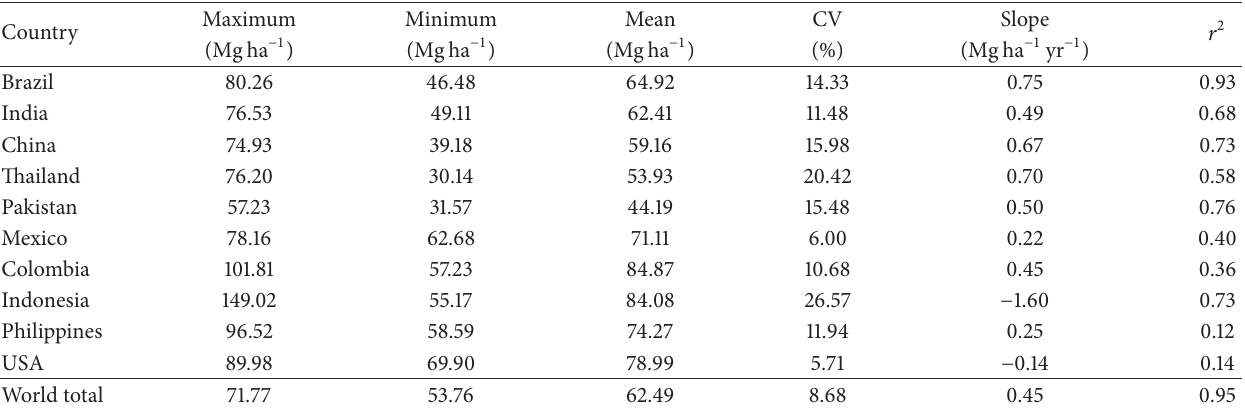
Table 2: Maximum, minimum, and mean cane yields and coefficient of variation (CV) across last 41 years (1973–2013) for the world top 10 sugarcane production countries. The slope and 𝑟 2 values of linear regression cane yield and year for each country are listed in the table † .